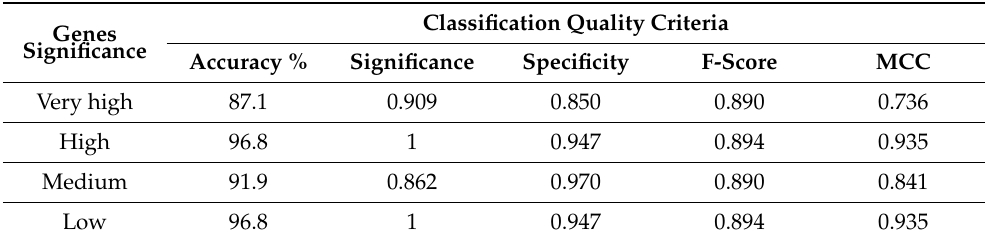
Table 1. Simulation results regarding the classification of objects based on gene expression data of various significance level when applying the Harrington desirability method.